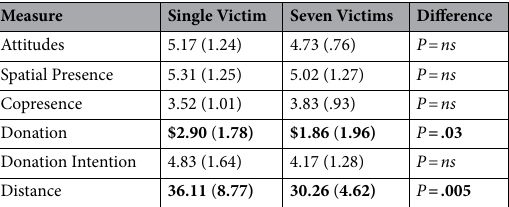
Table 1. Mean and standard deviation of dependent measures in Study 1.